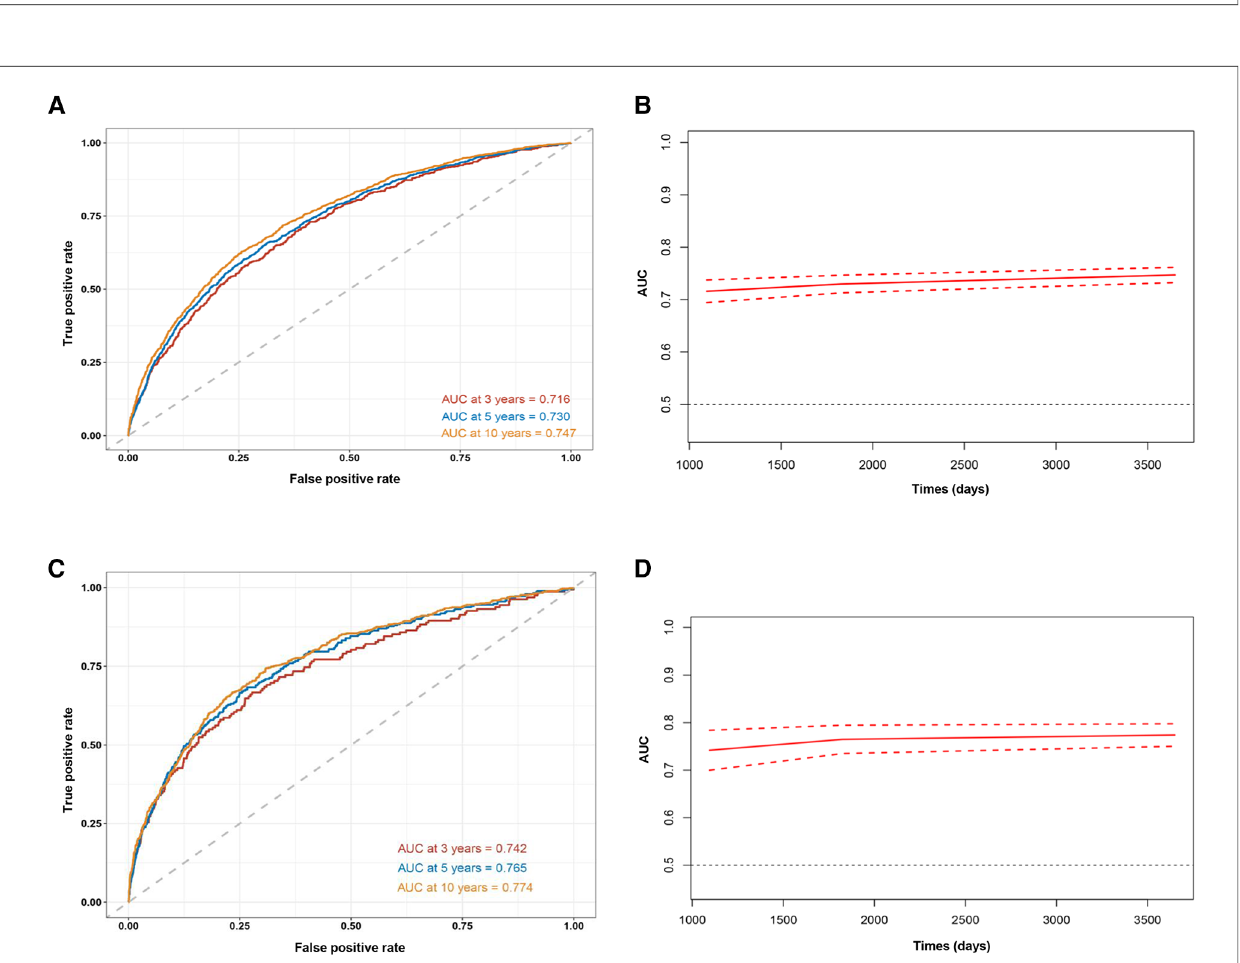
FIGURE 4 Time-dependent ROC curves (A) and time-dependent AUC values (B) of ePWV predicting all-cause mortality, and time-dependent ROC curves (C) and time-dependent AUC values (D) of ePWV predicting cardiovascular